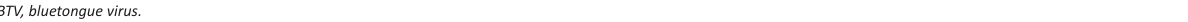
FIGURE 4: Neighbour-joining tree constructed using nucleotide sequence data of segment eight sequences of the 11 suspected reassortant isolates and the six parental viruses. Samples 2b and 6 illustrate a genome segment shift as they group with bluetongue virus vaccine strain